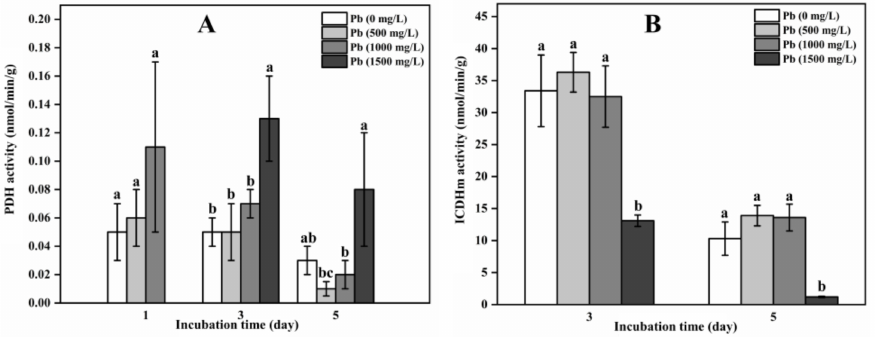
Figure 3. The enzyme of PDH ( A ) and ICDHm activity ( B ) in different lead concentrations during the incubation time (1, 3, and 5 days). The error bars represent the standard deviations of three replicates for each treatment. The different lower-case letters indicate a significant difference between the treatments ( p < 0.05).